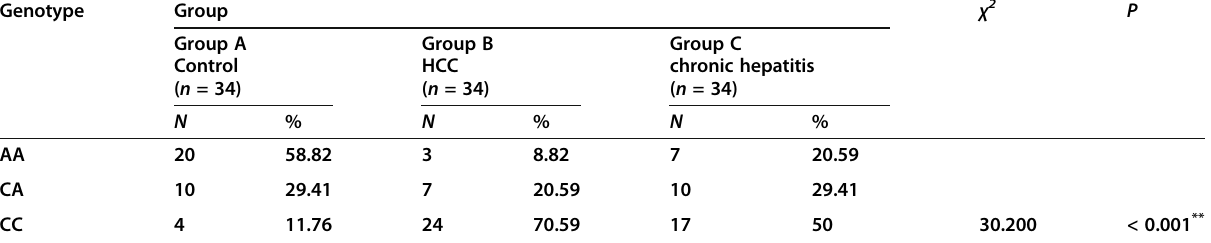
Table 2 Comparison between the three studied groups according genotypes distribution Genotype